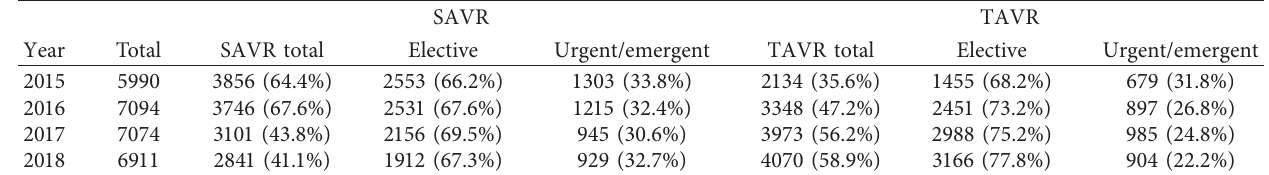
Figure 3: Rates of 1-year all-cause mortality categorized by the distressed communities index group. Table 5: TAVR/SAVR in New York